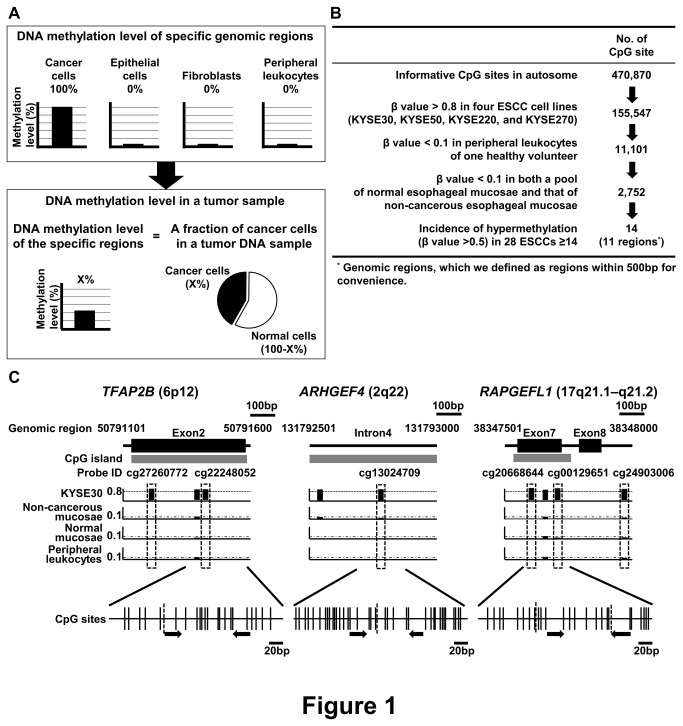
Selection processes of specific genomic regions.(A) The concept of estimation of the fraction of cancer cells in a tumor DNA sample using DNA methylation. (B) Selection of specific genomic regions, which were completely methylated in ESCC cells and completely unmethylated in various normal cells, by genome-wide methylation analysis using an Infinium HumanMethylation450 BeadChip array. Fourteen CpG sites were finally selected, and those were derived from 11 genomic regions. (C) Three genomic regions (TFAP2B, ARHGEF4, and RAPGEFL1) selected as components of a fraction marker. Gene structure and the location of a CpG island are shown at the top, and the β values of the CpG sites analyzed by the Infinium bead array are shown. The CpG site identified by the Infinium bead array is boxed by a rectangle with a dotted line. A CpG map around the CpG site(s) identified is shown at the bottom. Vertical lines (solid and broken) show CpG sites and broken lines show CpG sites whose β values were measured by the bead array. Closed arrows show primers for MS-HRMA.